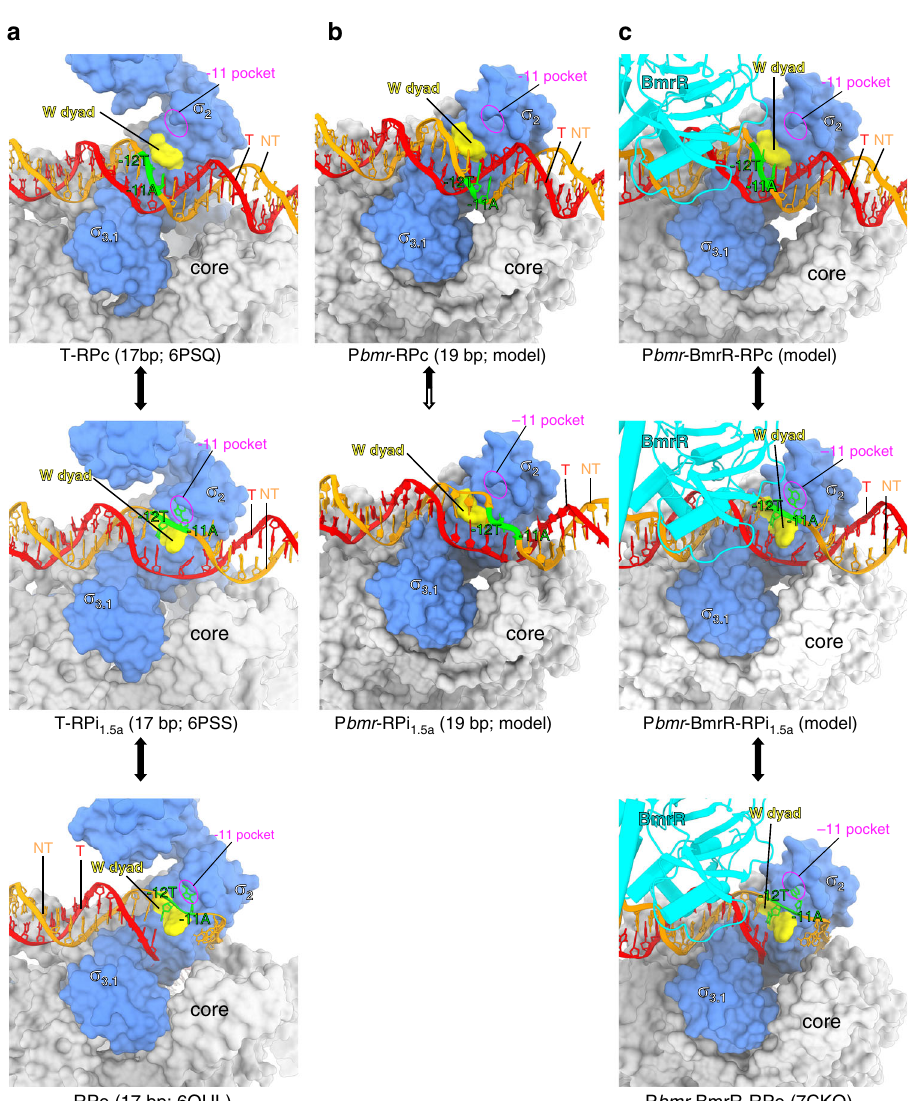
Fig. 5 The proposed mechanism of transcription activation by BmrR. a The simpli fi ed pathway of rps T2 promoter (17-bp − 35/ − 10 spacer) unwinding by E. coli RNAP- σ 70 holoezyme. The Ec T-RPc (PDB: 6PSQ; top panel), RPi 1.5a (PDB: 6PSS; middle panel), and RPo (PDB: 6PSW; bottom panel) were adapted from ref. 42 . b The proposed aborted pathway for unwinding P bmr by B. subtilis RNAP- σ A holoenzyme. The P bmr -RPc (upper panel) was built base on the Ec T-RPc (PDB: 6PSQ); the hypothetic intermediate of P bmr unwinding by B. subtilis RNAP- σ A promoter, in which the − 12 T:A base pair and − 11A is far away from the W-dyad and − 11A pocket, two key structural elements for protein unwinding, and the − 13T (nt) is not able to be secured by the − 11A pocket. c The proposed pathway for TPP-BmrR-bound P bmr unwinding by B. subtilis RNAP- σ A holoenzyme. The P bmr -BmrR-RPc (upper panel) was built base on the Ec T- RPc (PDB: 6PSQ); the P bmr -BmrR-RPi 1.5a (middle panel) was built base on the Ec T-RPc (PDB: 6PSQ); and the P bmr -BmrR-RPo was determined in this study. Red, template DNA; orange, non-template DNA; blue, σ A ; cyan, BmrR; yellow patch, W-dyad; purple circle, the − 11A